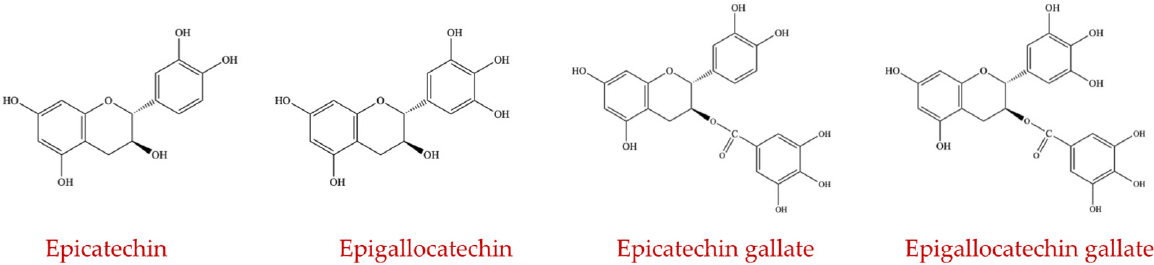
Figure 6. Chemical structures of flavanols (epicatechin, epigallocatechin, epicatechin gallate, and epigallocatechin gallate) (self ‐ generated) .